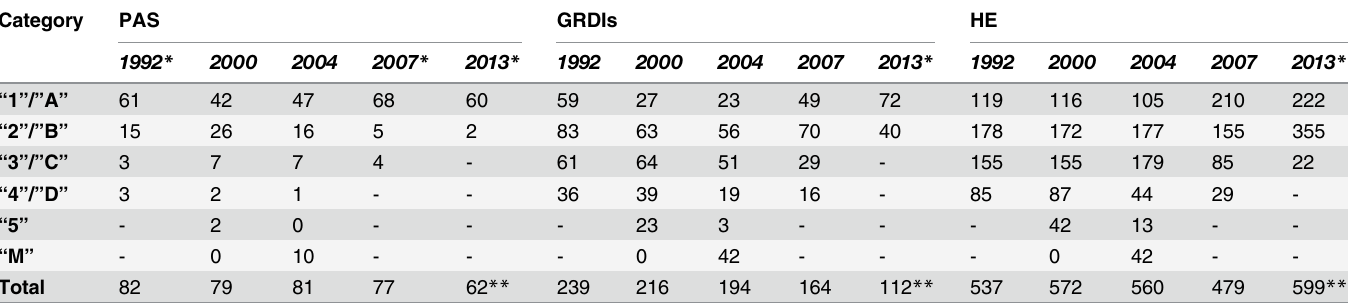
Table 2. Categories assigned in institutional ranking by KBN (1992 – 2004) and the MNiSW (2007), published in Official Journals [43].